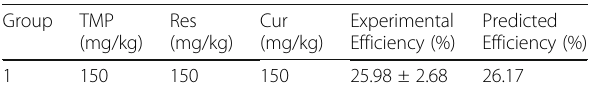
Table 3 Predicted and experimental efficiency of the optimal formulation on acute inflammatory mice model